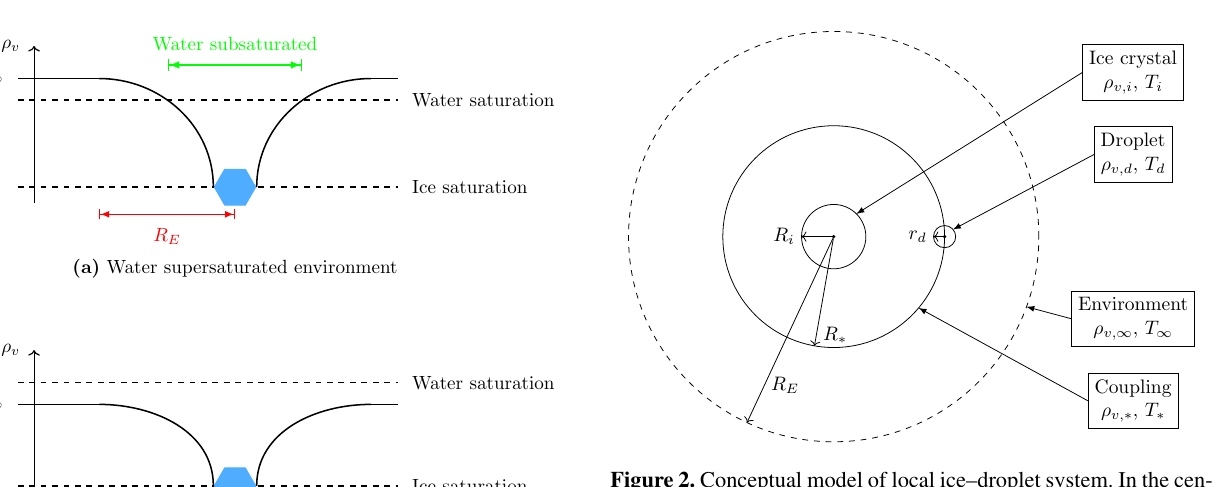
Figure 2. Conceptual model of local ice–droplet system. In the cen- ter is an ice crystal with radius R i and at distance R ∗ from the ice crystal is a cloud droplet with radius r d . The presence of the ice crystal gives rise to an influence sphere with radius R E around the ice crystal. Distance R ∗ is the coupling distance at which the diffu- sional growth of the hydrometeors is